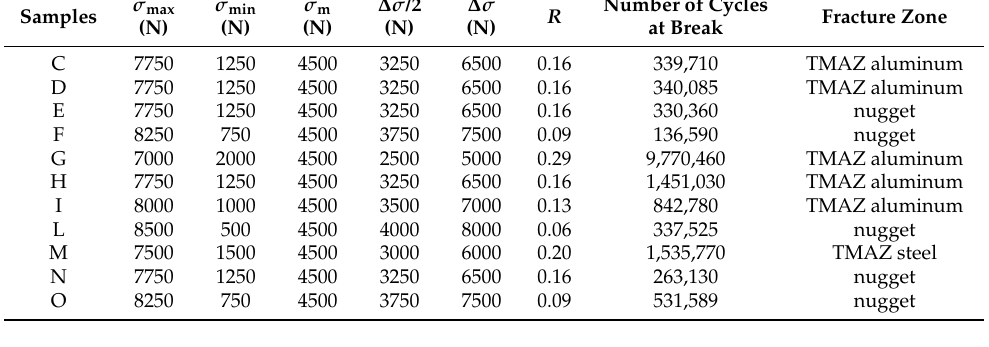
Figure 12. Fracture zone for welding 957 specimen ( a ) and welding 3 specimen ( b ).